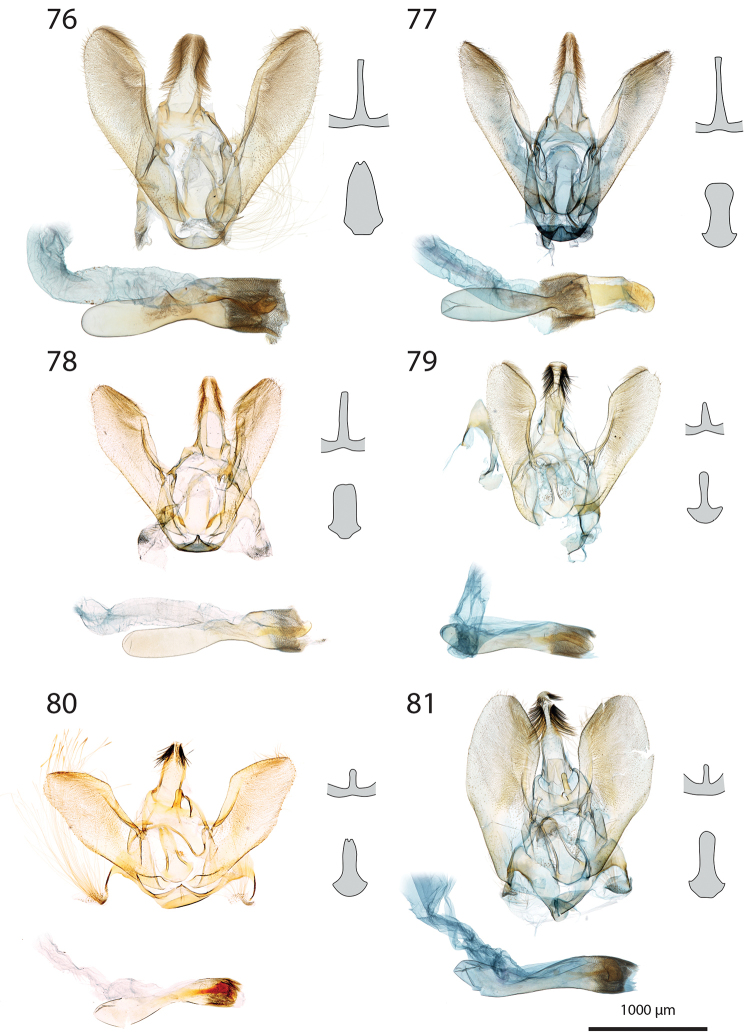
Male genitalia features of Hoploscopa. 76Hoploscopa
mallyi sp. nov., paratype, TL339 ♂ 77Hoploscopa
gracilis sp. nov., paratype, TL539 ♂ 78Hoploscopa
agtuuganonensis sp. nov., paratype, TL675 ♂ 79Hoploscopa
boleta sp. nov., holotype, TL440 ♂ 80Hoploscopa
pseudometacrossa sp. nov., paratype, TL441 ♂ (uncus apex missing) 81Hoploscopa
metacrossa, TL443 ♂.